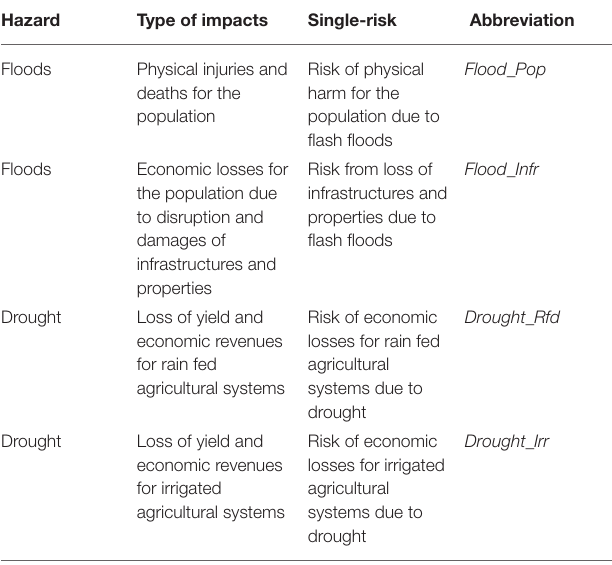
TABLE 1 | Table of single-risks selected for the construction of the multi-risk assessment. Hazard Type of